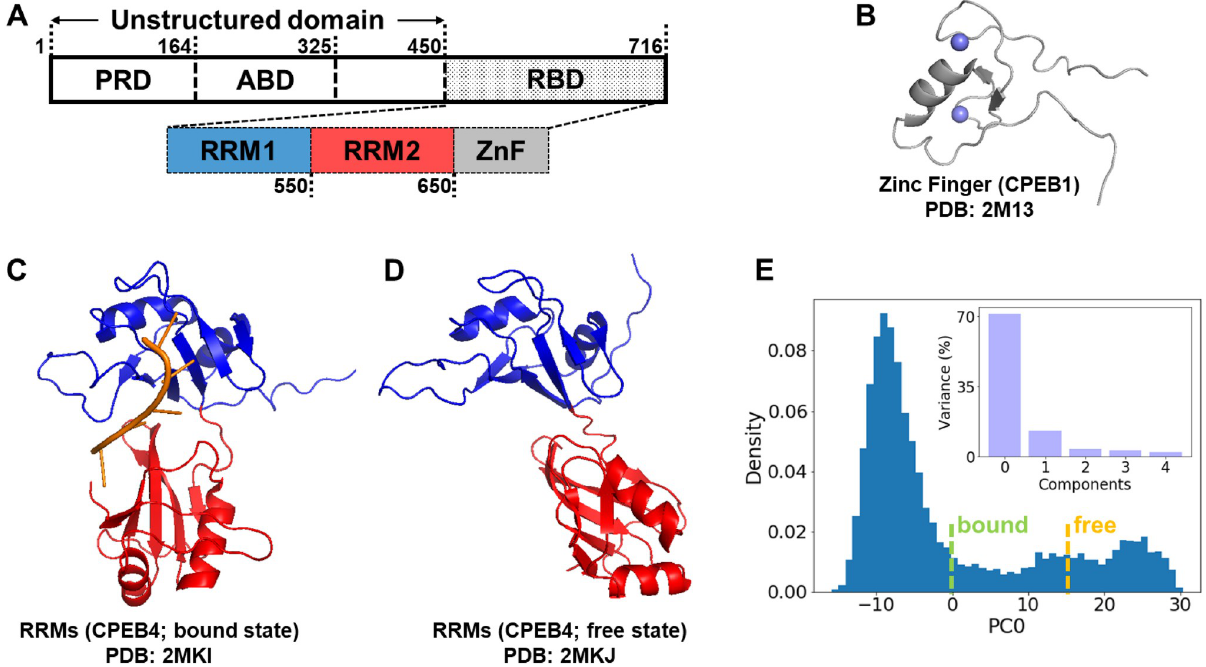
Fig 2. A . A diagram of the CPEB3 subdomains including a prion-like domain (PRD), an actin-binding domain (ABD), and an RNA-binding domain (RBD). The RBD consists of two RNA recognition motifs, RRM1 and RRM2 (colored in blue and red hereinafter), and one Zinc-finger domain (ZnF, colored in grey). B . The NMR structure of CPEB1 ZnF (Zinc ions are shown in purple). C . The NMR structure of CPEB4 RRMs binding with target mRNA (shown in orange). D . The NMR structure of free CPEB4 RRMs. E . The histogram for the distribution of first principal component, PC0, sampled during 20 equilibrium simulation trajectories of CPEB3 RRMs. Embedded: Variance contributed by the first five principal components from the principal component analysis. The PC0 values for the NMR structures of the RNA-bound state and the free state are shown by green and yellow dashed lines,